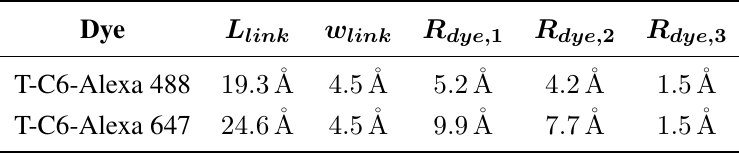
Table 3. Dimensions of the dye-linker constructs for dyes attached to DNA at position 5' of a thymine (T) via a C6 amino linker. Notation according to